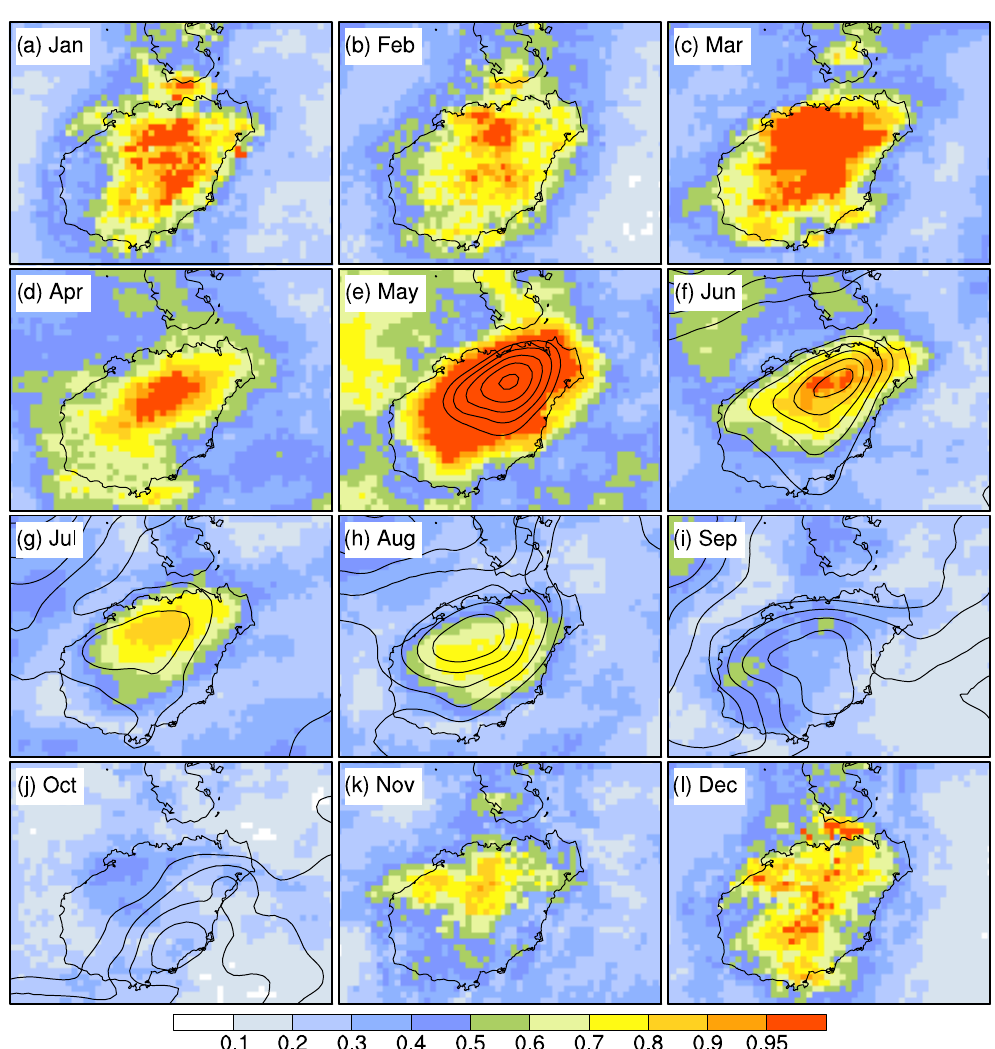
Figure 4. Fraction of the total precipitation that can be attributed to the diurnal cycle by month (shading), along with average hourly precipitation accumulations (black contours every 0.05mm, starting at 0.25mm).